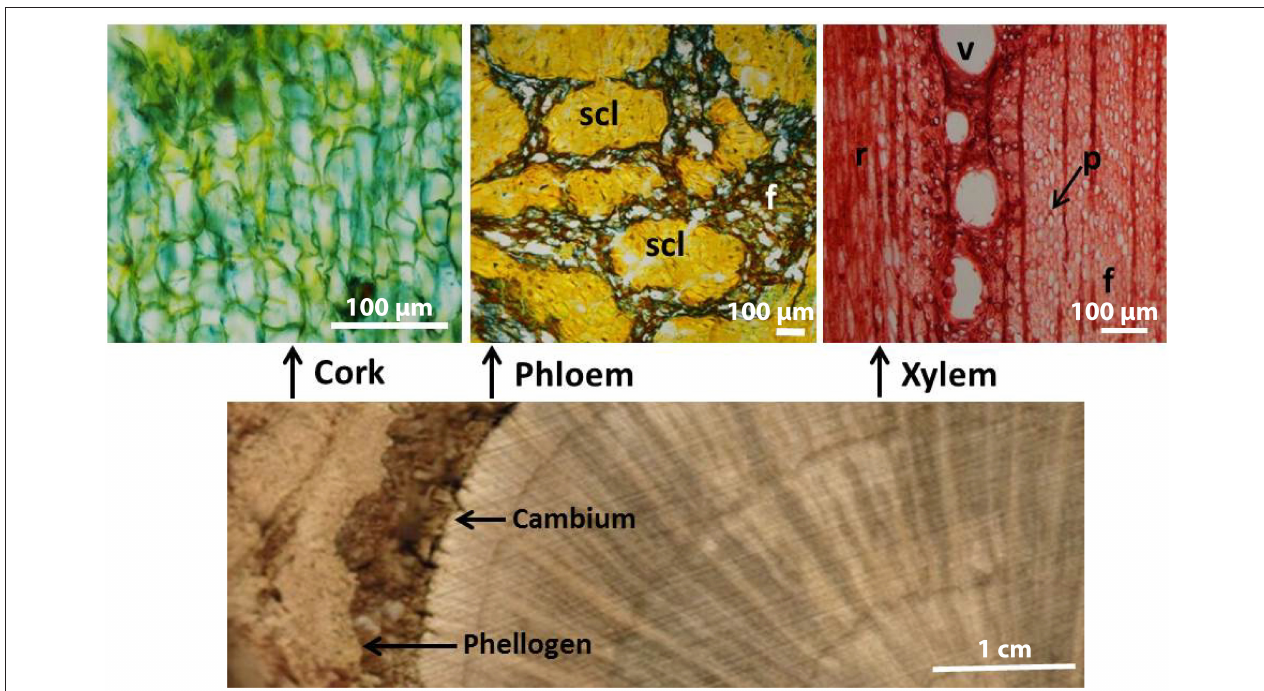
FIGURE 1 | Cross-sectional image of a Quercus suber stem disc presenting cork, phloem, and xylem (scale bar = 1 cm), and transverse microscopic sections of cork, phloem, and xylem tissues (scale bar = 100 µ m). scl, clusters of sclereids; f, fibers; v, vessel; r, rays; p, parenchyma.